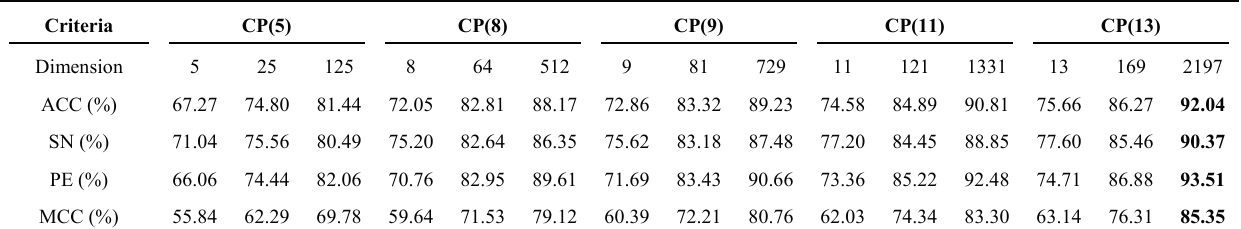
Table 6. Comparisons of the weighted sparse representation-based classification (WSRC) and support vector machine (SVM). (The numbers in bold is the best result.). Criteria